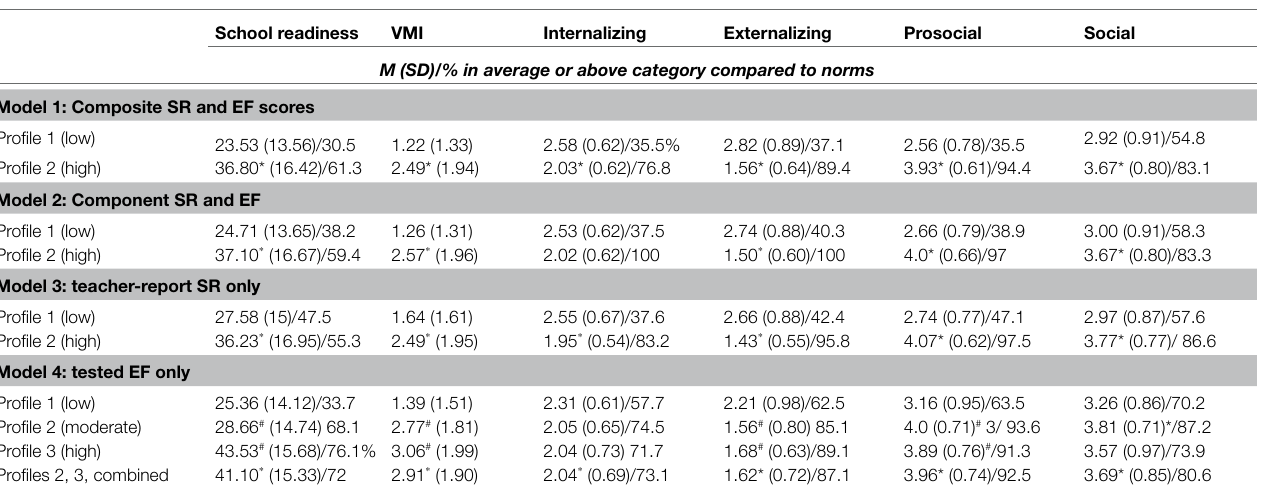
TABLE 5 | Differences across profiles on outcome measures. School readiness VMI Internalizing Externalizing Prosocial